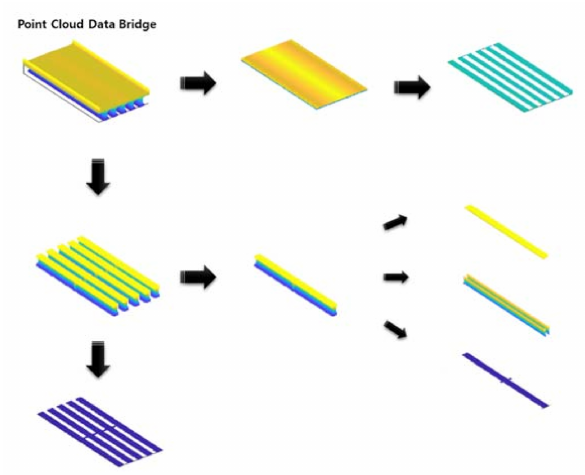
Figure 9. Bridge point cloud data decomposition.